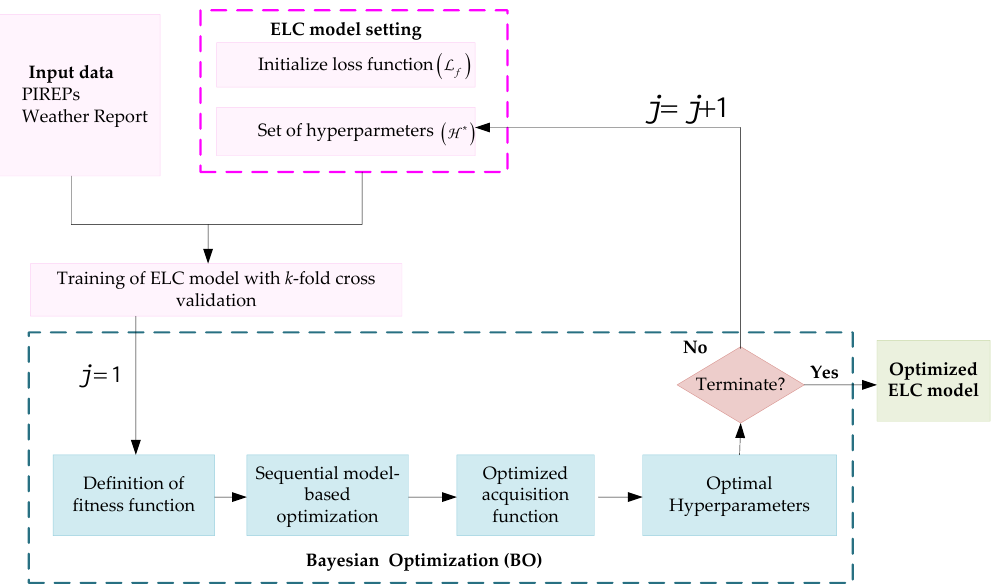
Figure 5. Hybrid BO-ELC approach for the prediction of LLWS criticality.